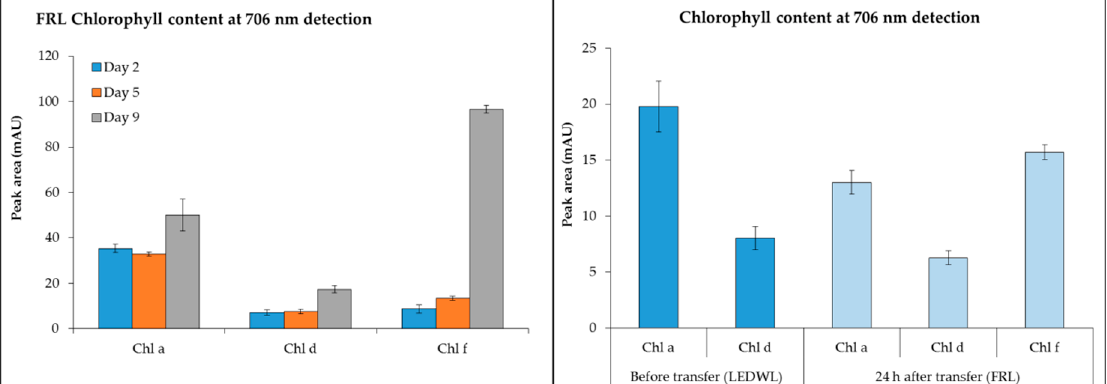
Figure 3. Chlorophyll content (chl a , chl d , and chl f, detected at 706 nm) of C. fritschii exposed to FRL at day 2, 5, and 9 and LEDWL (day 9) and 24 h after transfer into FRL (day 10).